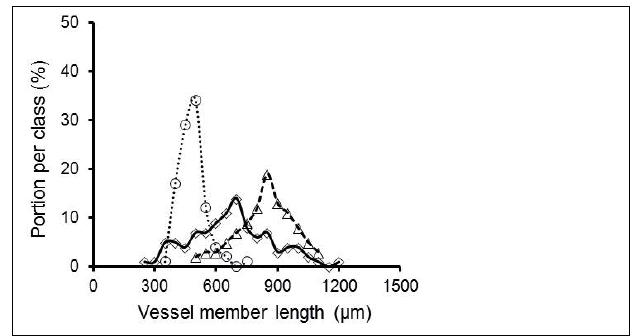
Fig. 3: Class size distribution (%) of vessel member length (µm) in the xylem of the phenotypes “Amarelinha” (rough dotted line), “Cinza” (fine dotted line), and “Sassafras” (full line). Class size: 50 μm. 1500 measurements per